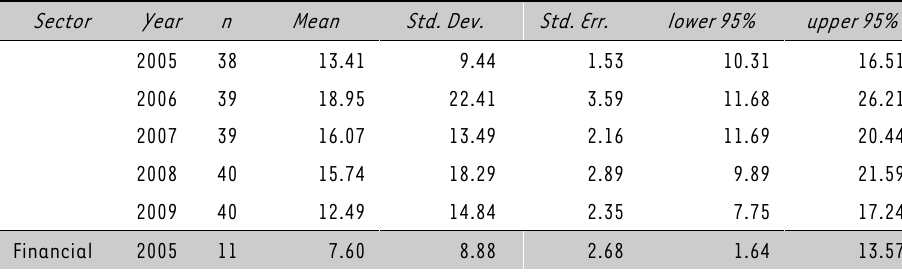
TABLE 9: Descriptive statistics for ROA All figures except for n are given as a